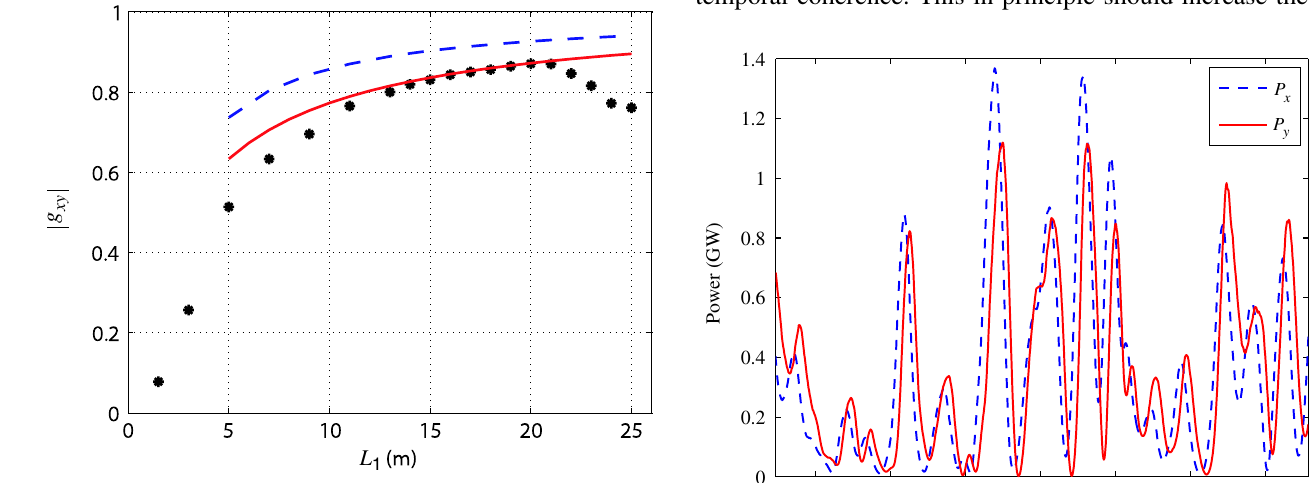
j from the xy j when h P i (cid:4) h P i . FIG. 4. (Color) GENESIS simulated power profiles of the hori- xy x y zontal field (blue dashed curve) and the vertical field (red solid curve) at the end of the second undulator, bunch head at left.